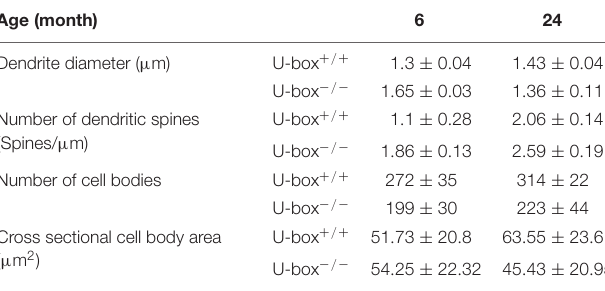
TABLE 2 | Morphological properties of Purkinje cells in wild-type and U-box − / − fish at indicated time